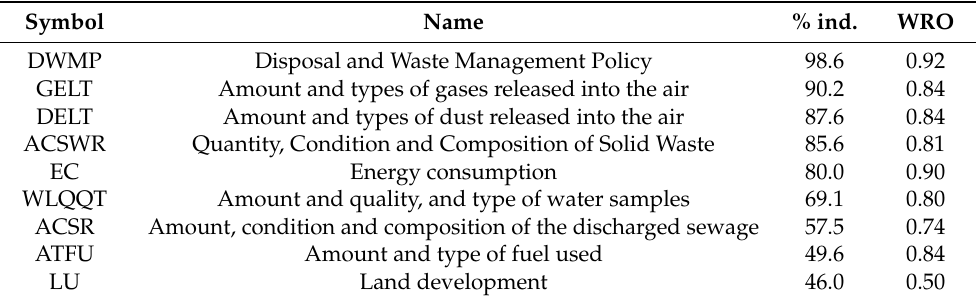
Table 1. Characteristics of the examined indicators—obligatory environmental indicators. Source: Own study,